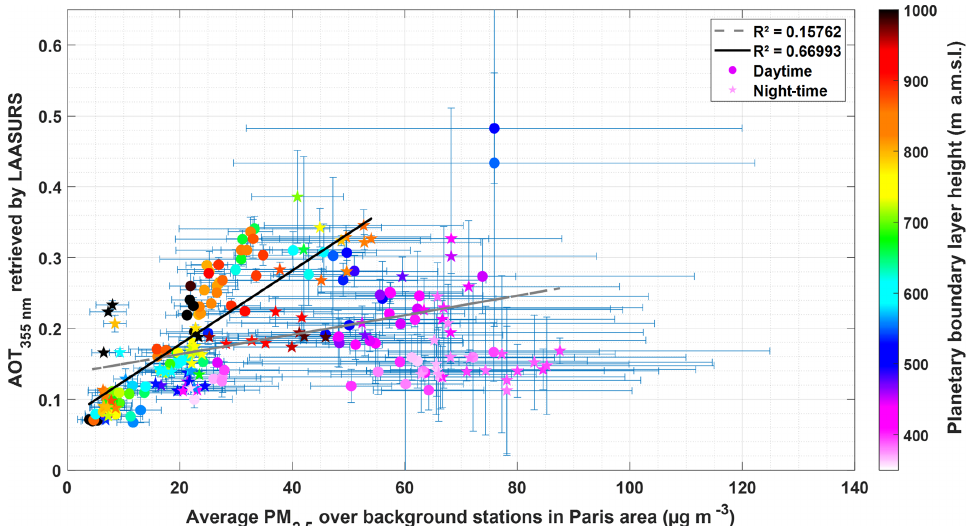
Figure 11. Relationship between PM 2 . 5 ( x axis) and aerosol optical thickness retrieved by lidar at 355nm (AOT lid ) ( y axis) for the dataset presented in Figs. 7 and 10 overlapped. The colour set indicates the PBL height retrieved by lidar for each point. Error bars represent the standard deviations due to time average (AOT lid ) and spatial average (PM 2 . 5 ). The daytime (nighttime) data are represented by discs (stars). The grey dashed line (black solid line) illustrates the linear regression computed from all the trend lines (the set of points associated with a PBL top above 600ma . m . s . l . ). The correlation coefficients can be found in the top right-hand